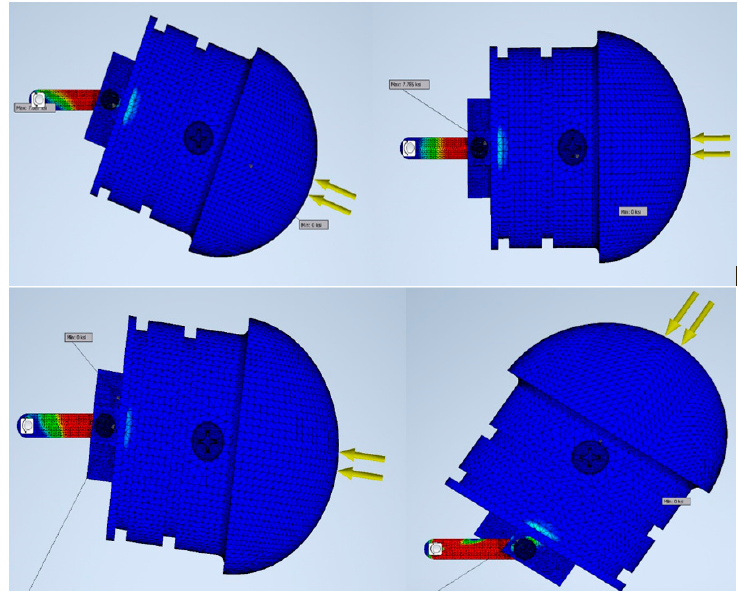
Figure 13. Stress analysis (FEA) used to simulate the dynamic modelling.